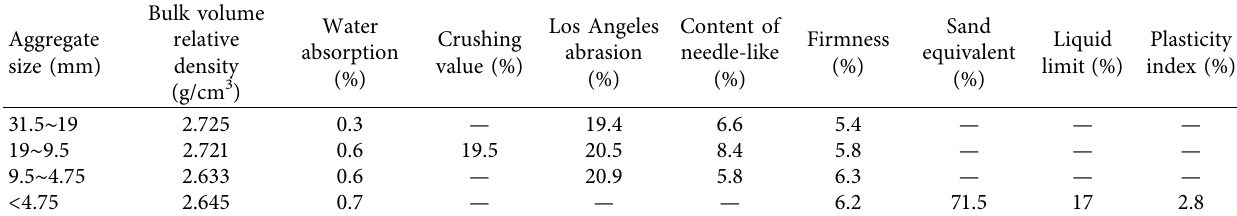
Table 1: Technical properties of aggregates.